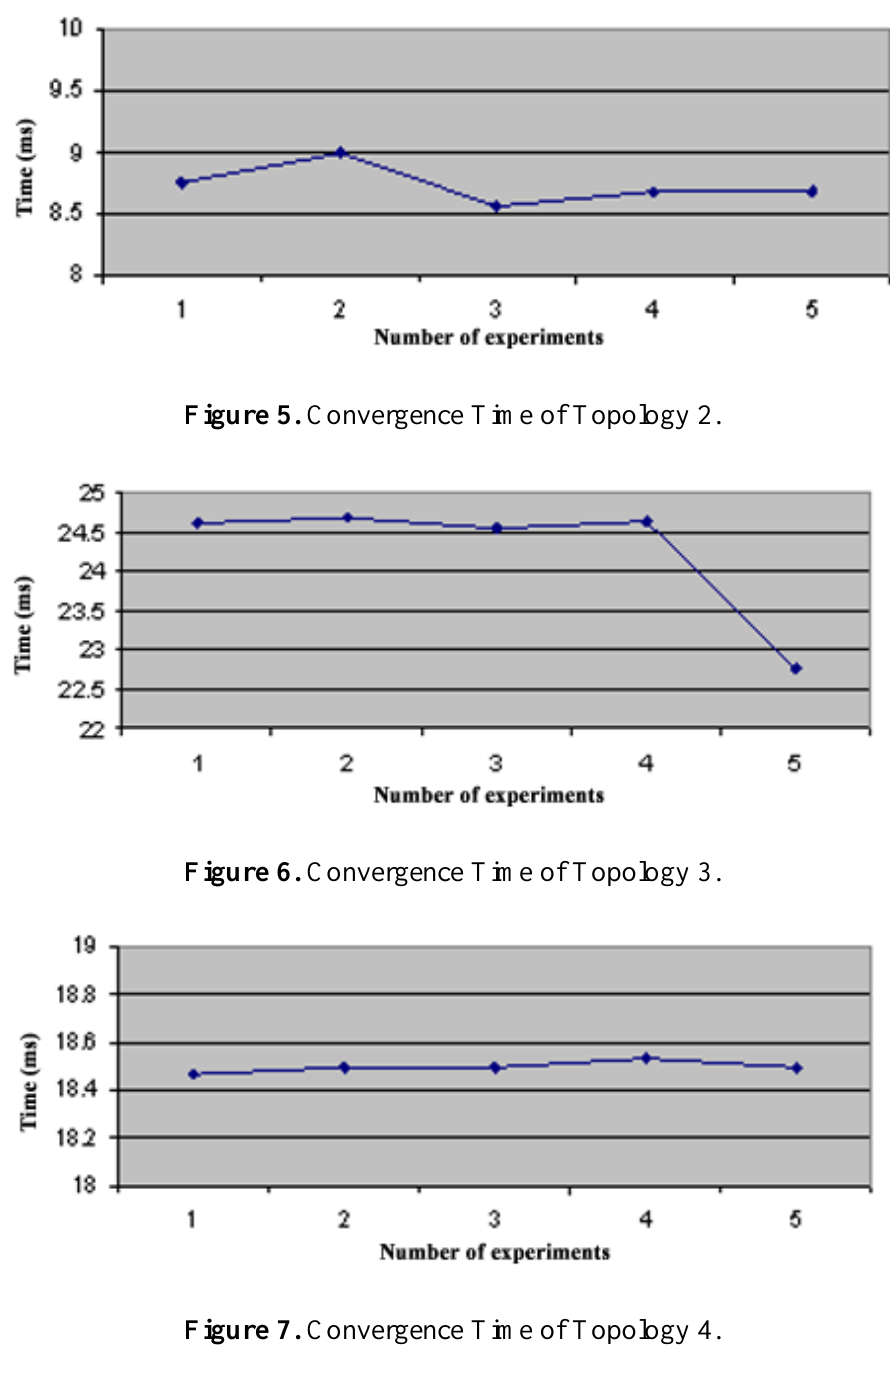
Figure 4. Convergence Time of Topology 1.